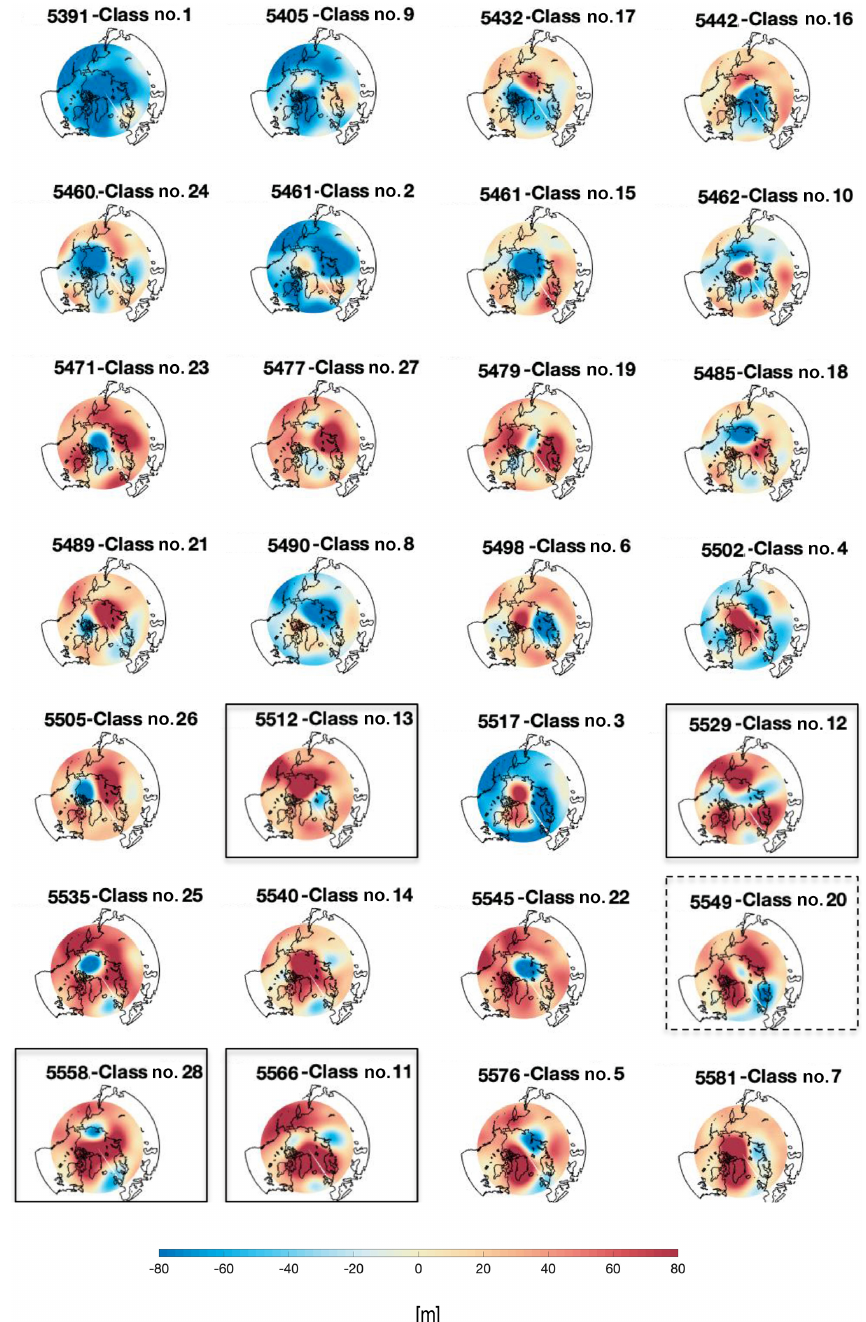
Figure 14. Mean 500hPa GPH anomalies for the 28 classes identified by the SOM using the NCEP/NCAR reanalysis data for the period 1948–2019 ordered from the lowest to the highest mean GBI values computed using those days when the classes were